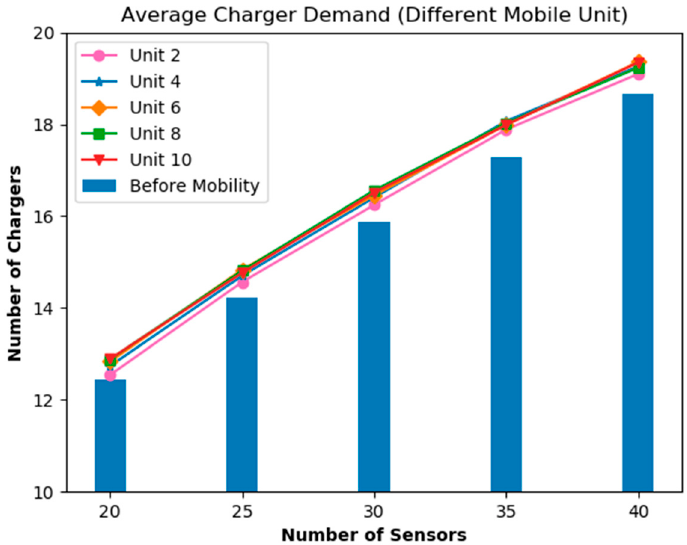
Figure 12. The impact of different mobility units and the number of chargers used for SMRU to adjust the position of chargers after sensor mobility.